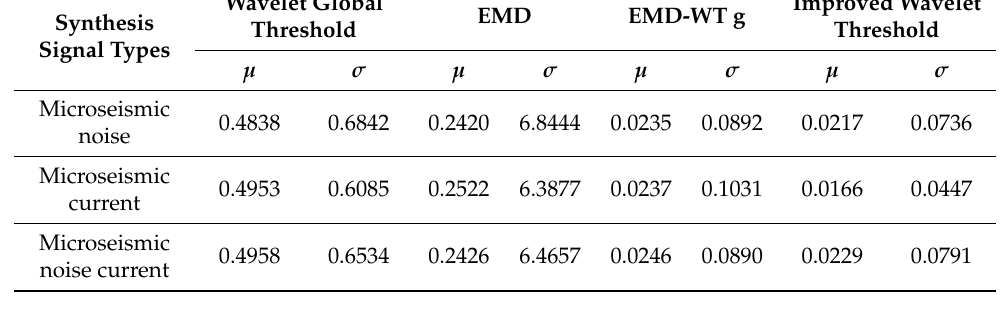
Table 3. Comparison of evaluation indicators for different types of synthetic signals.